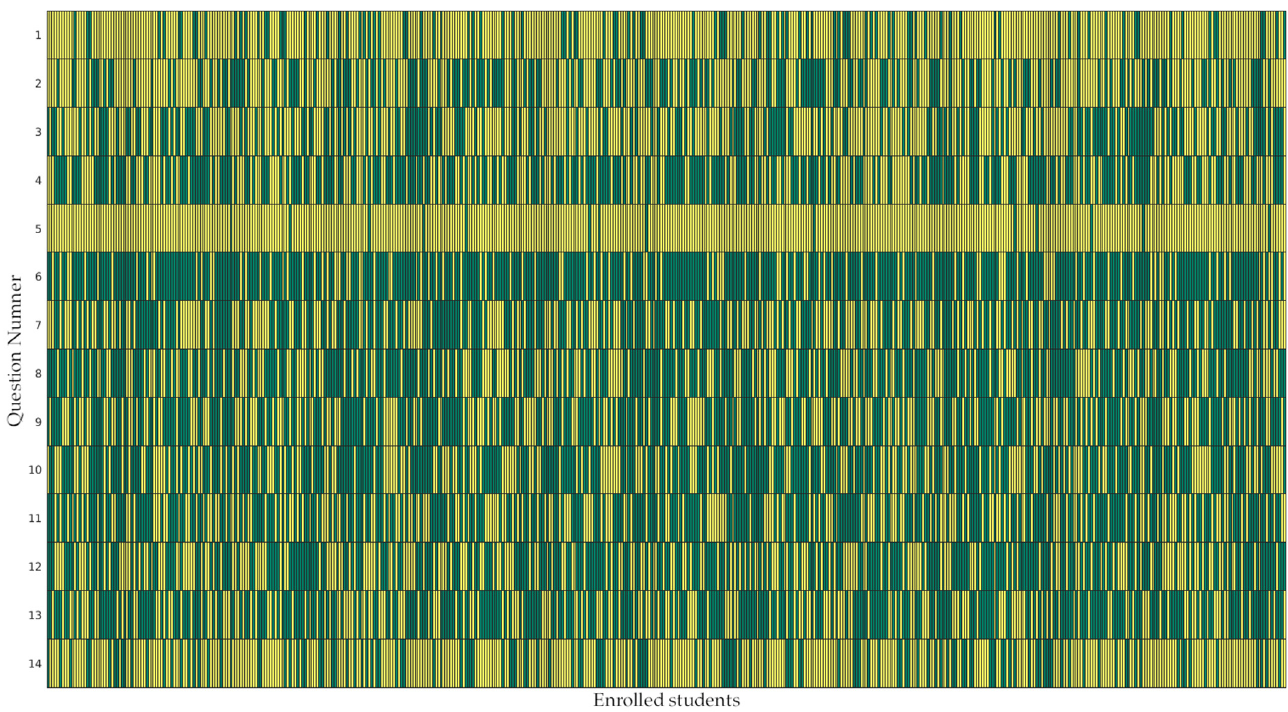
Figure 1. Answers distribution in the sample of students. The answer “NO” is represented in green, while the answer “YES”